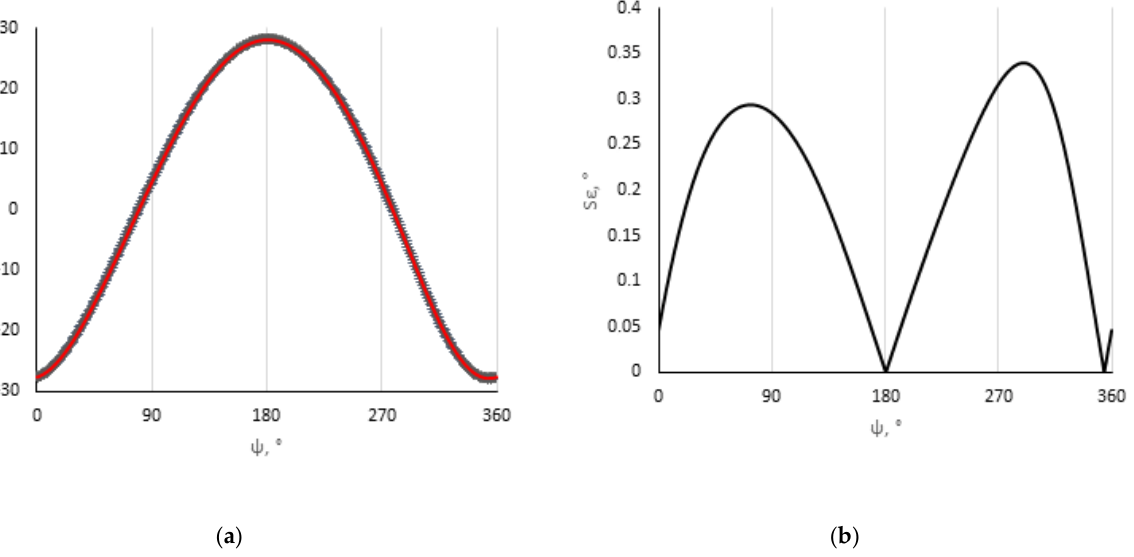
Figure 8. Curve illustrating : ( a ) values of composite quantity θ together with standard measuring uncertainty due to the measurement of d . ( b ) standard measuring uncertainty values for composite quantity θ due to the measurement of d .